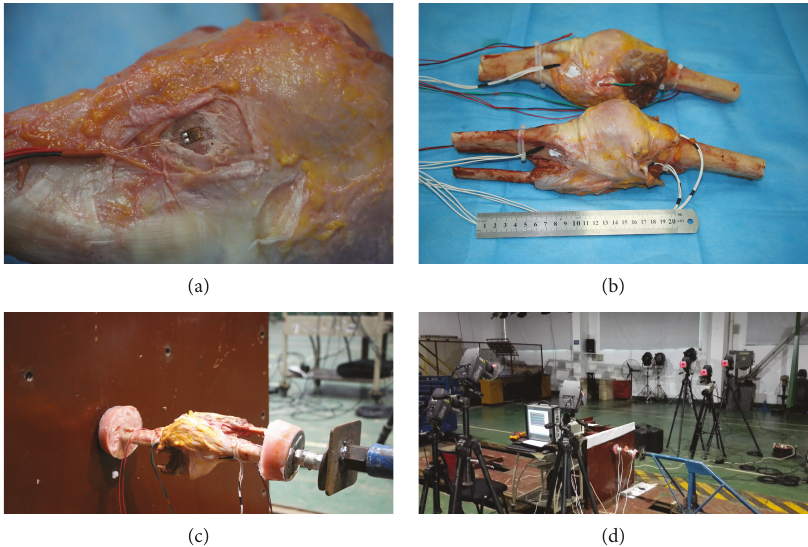
Figure 1: Photos of the experimental device to assess longitudinal impact on knee joints. (a) Method for implanting the knee joint strain sensing plate. (b) Condition after double knee electrode implantation. (c) Knee impact unit settings. (d) Traction track and Synergy version 5.0 data acquisition